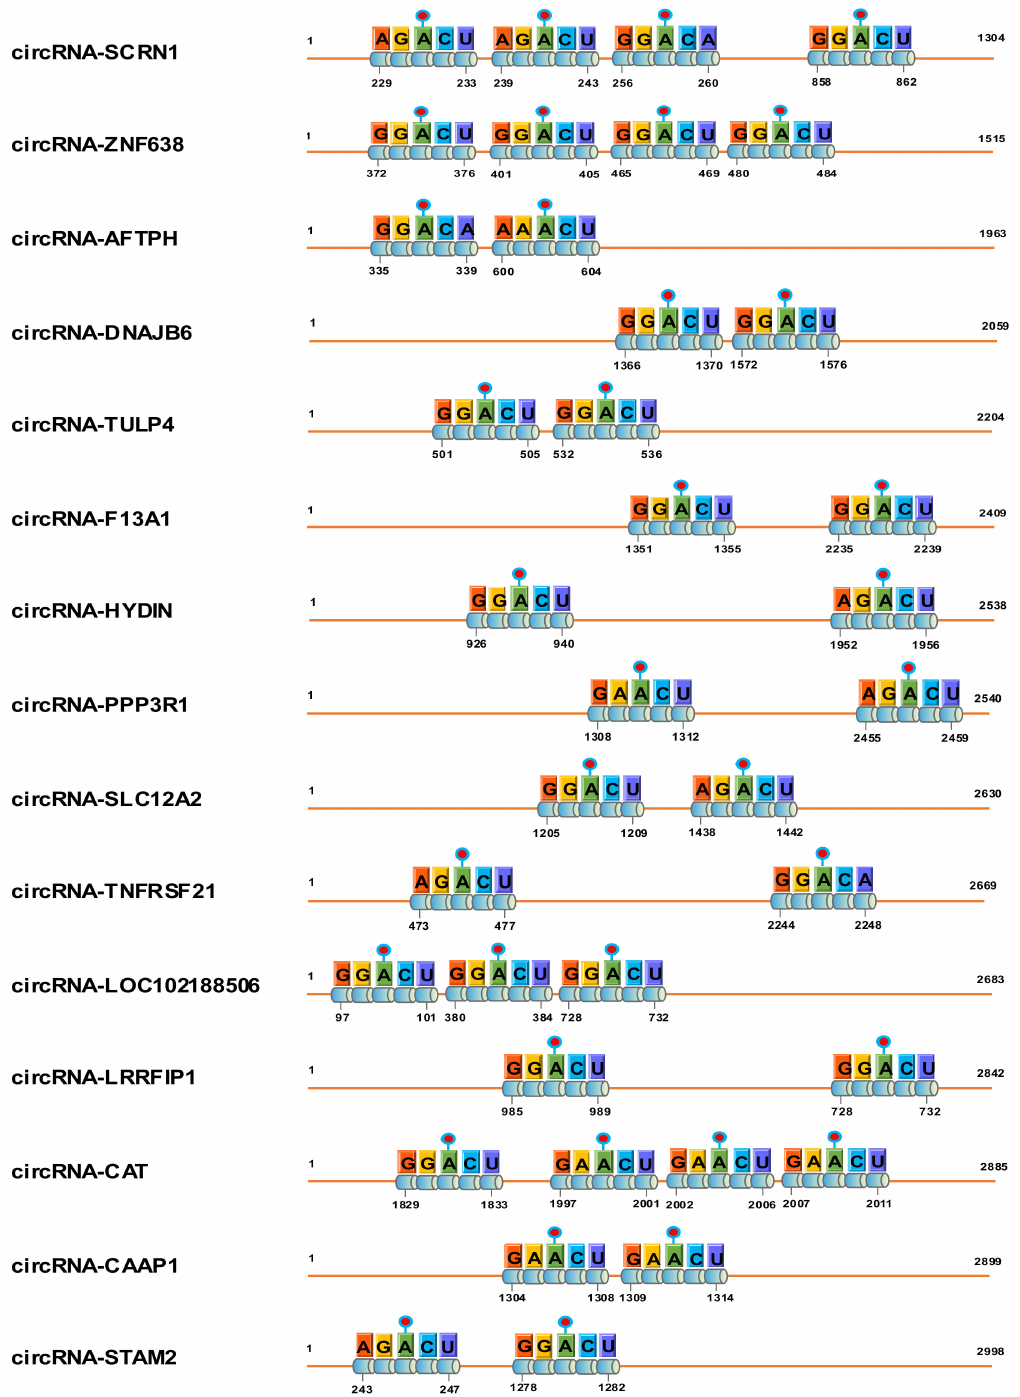
Figure 2. Diagram of putative m 6 A sites within 15 circRNA sequences from skin tissue of cashmere goat. The orange thin line represents circRNA sequence, and the motifs of m 6 A sites are shown within each circRNA sequence with the corresponding nucleotide positions. The putative m 6 A sites were predicted using the SRAMP program (http://www.cuilab.cn/sramp, accessed on 11 July 2021) and the only m 6 A site motifs are shown in each circRNA sequence with very high confidence in SRAMP